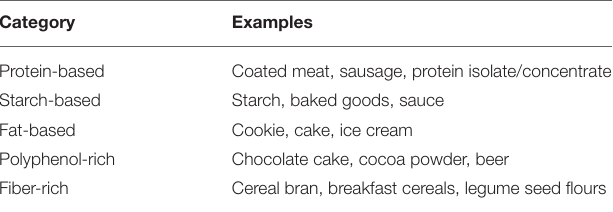
TABLE 2 | Suggested matrix categories and examples for foods from each